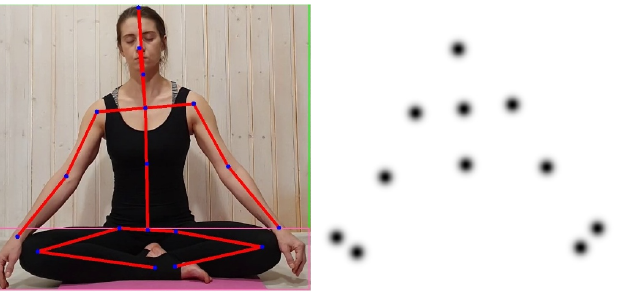
Figure 3. Application of Gaussian function to calculate displacement